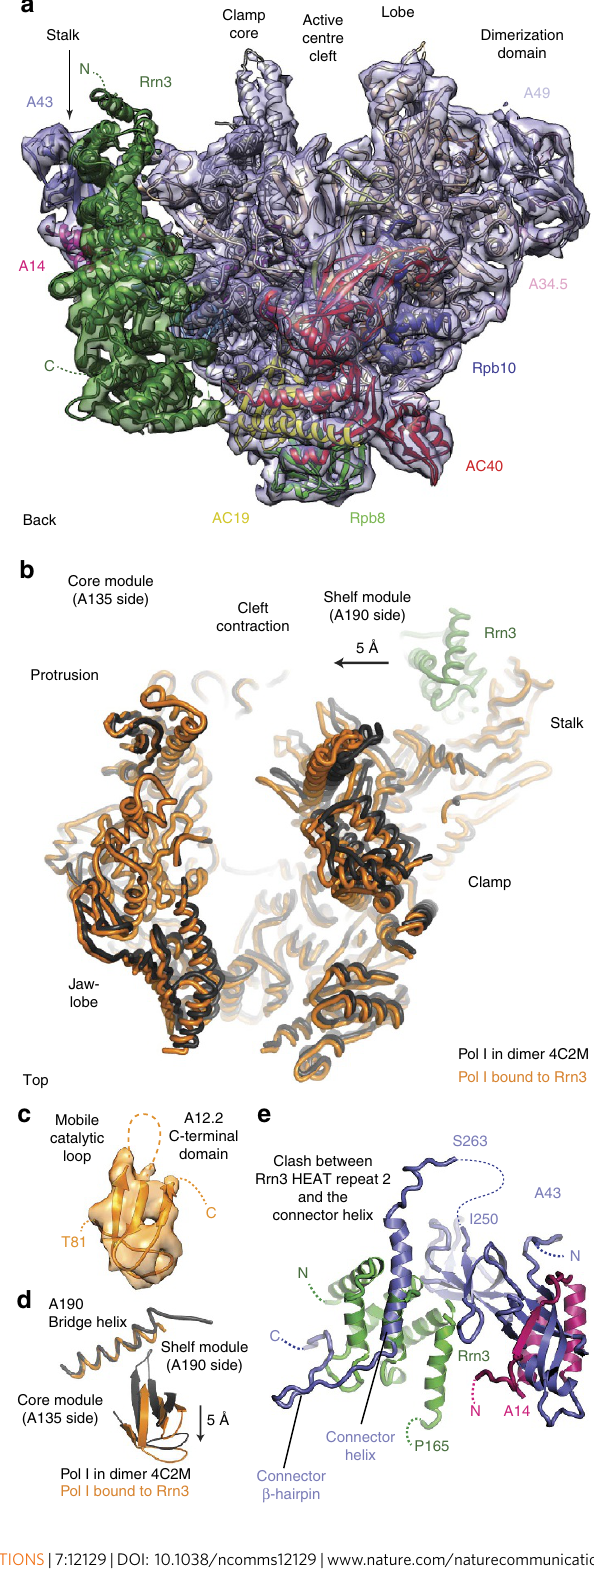
Figure 1 | Cryo-EM structure of the Pol I–Rrn3 complex at 4.8 Å resolution. ( a ) Overview of the cryo-EM density (mesh) with fitted atomic structures (ribbon models) of Pol I (subunits in previously used colors 6 ) and Rrn3 (green). The view is from the back 33 . ( b ) Partial cleft closure observed by superposition of the expanded dimeric Pol I crystal structure (black, PDB-code 4C2M) and the partially contracted, Rrn3-bound form (orange). The A135 subunits were superimposed. ( c ) The A12.2 C-terminal domain shows cryo-EM density and is well defined in the Pol I–Rrn3 complex structure, although the catalytic loop is mobile. ( d ) Rotation of the A12.2 C-terminal domain compared with the position observed in the free Pol I structure. The nearby bridge helix is partially rewound. ( e ) Superposition of the free Pol I crystal structure onto the Pol I–Rrn3 complex structure reveals that the connector (space filling, blue) would clash with the three N-terminal HEAT repeats of Rrn3